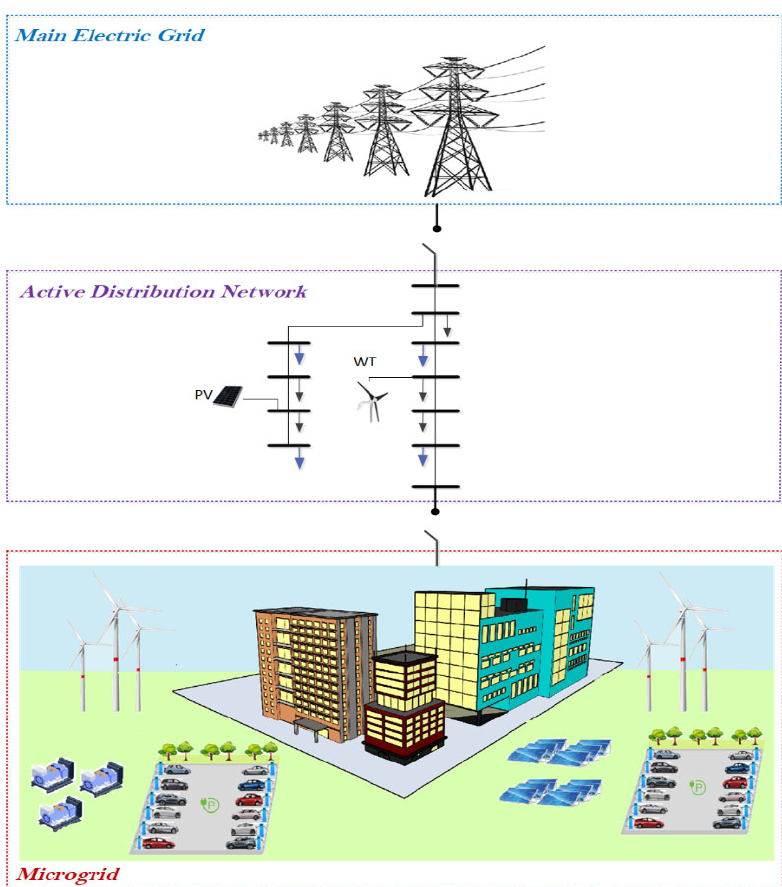
Figure 1. Configuration of the proposed system.